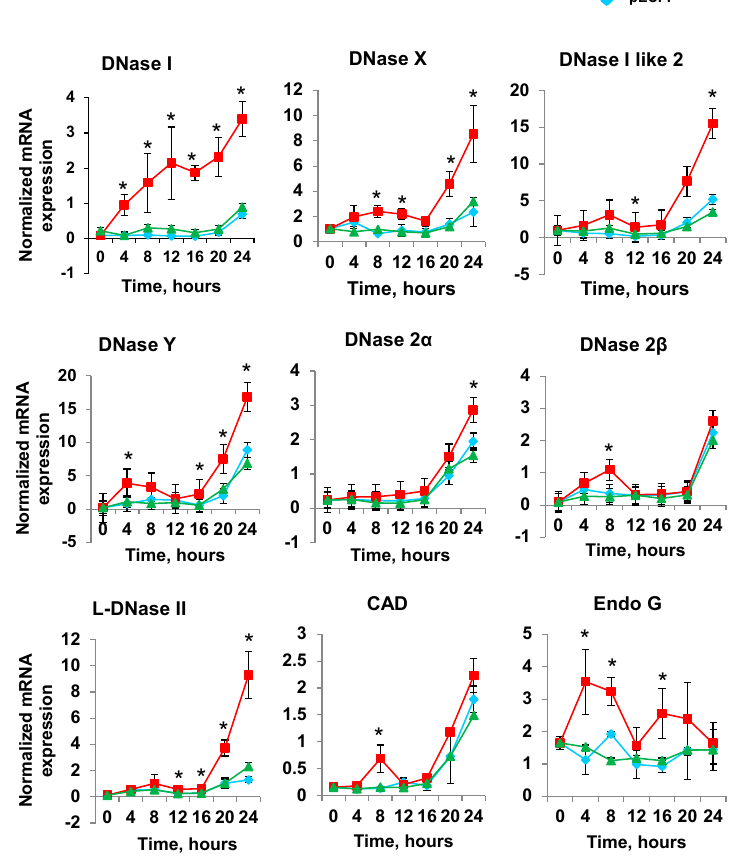
Figure 2. DNase I overexpression causes induction of other endonucleases. NRK-52E cells were transfected with pECFP, pECFP-DNase I or pECFP-MT3cA and mRNA expressions of